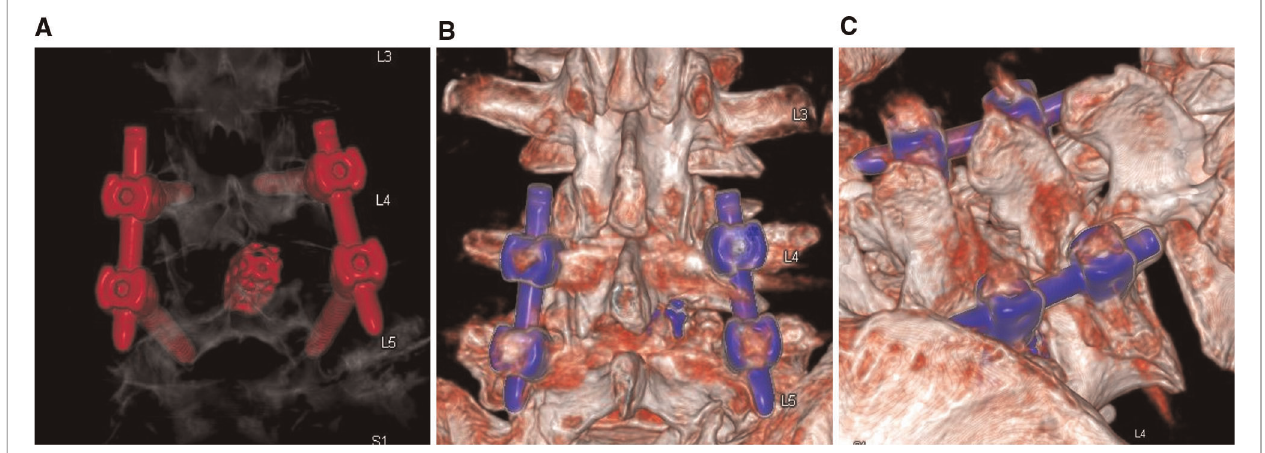
FIGURE 3 | CT reconstructed images. ( A,B ) The extent of intraoperative laminectomy and facetectomy. ( C ) The base of the spinous process is